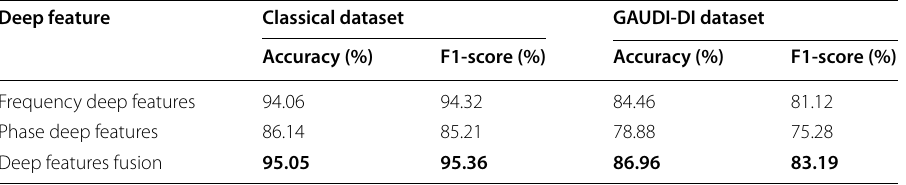
Bold means the best performance of tampering detection in the same experimental setting